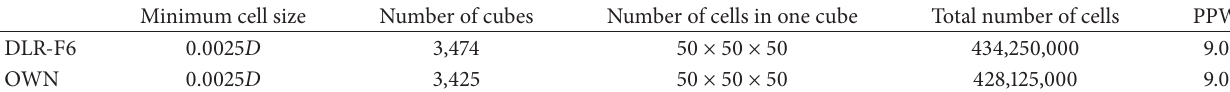
Table 5: Mesh information for calculations of noise propagation around the fuselage-wing-nacelle configurations.